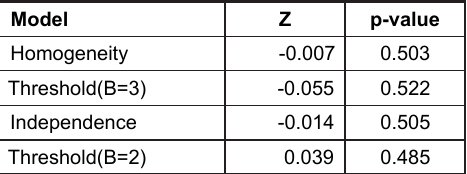
Table 9. Tests for randomness of collared caribou across groups for the Bluenose-West 2005